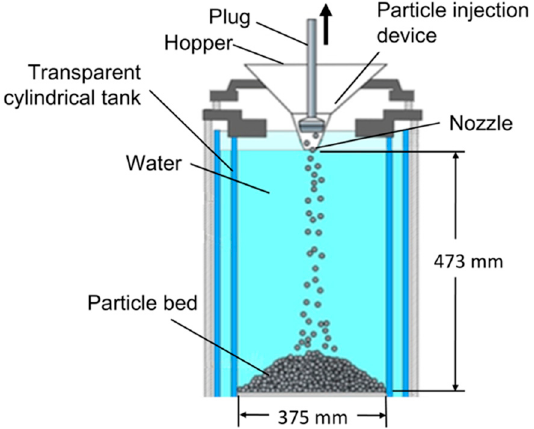
Figure 1. Schematic illustration of the setup for the particle sedimentation experiments.